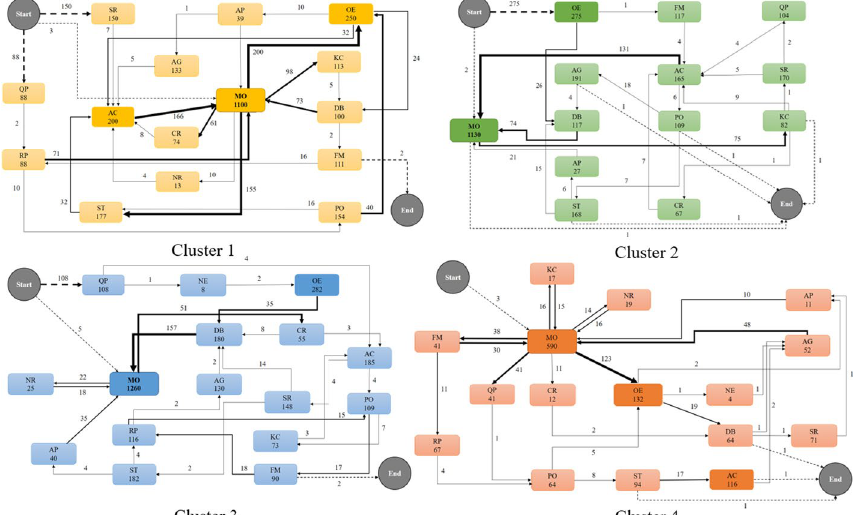
Fig. 5 The process mining results of four collaborative clusters. In the process models, the boxes refer to the absolute frequencies of codes and the arrows refer to the observed directional transitions from code A to code